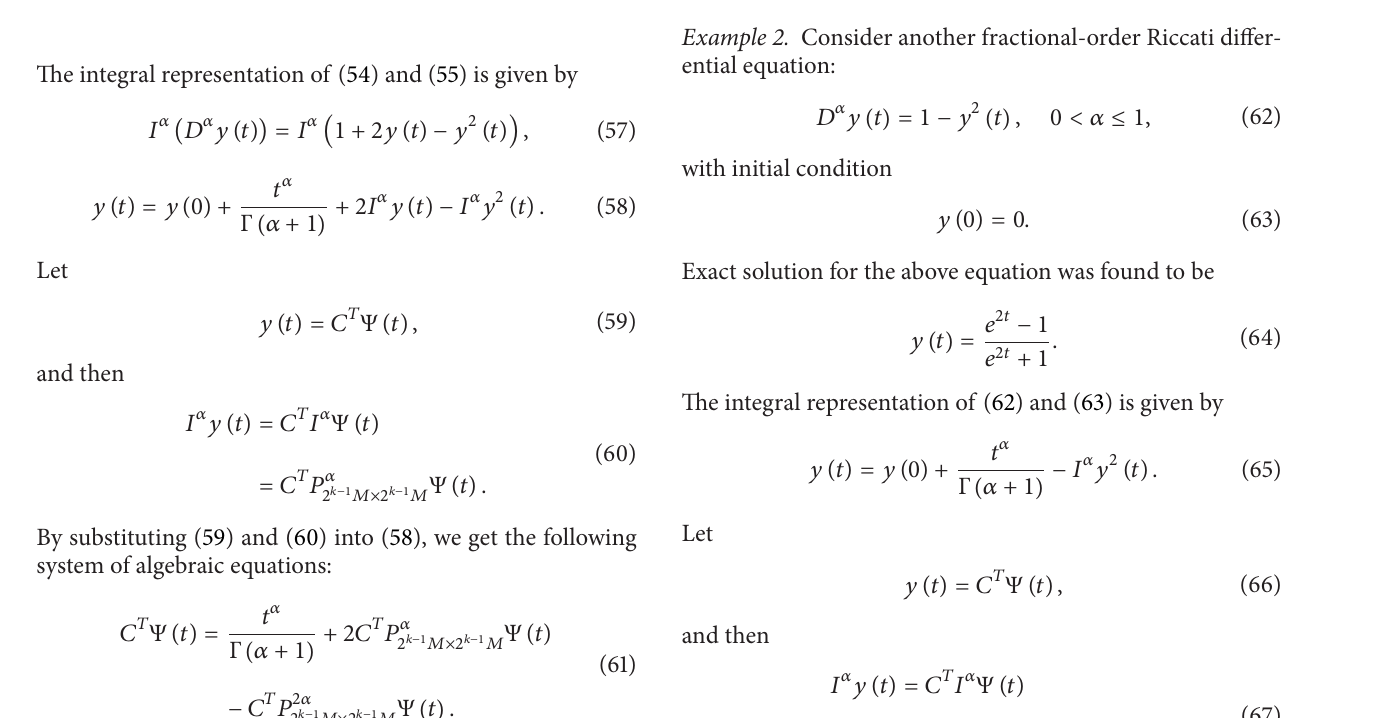
Figure 1: Numerical results of Example 1 by LWM for 𝛼 = 1 .